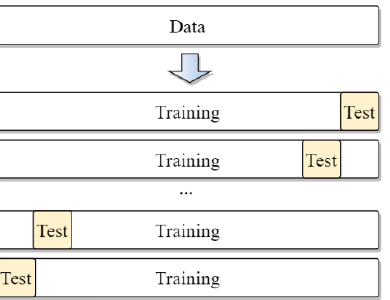
Figure 9. 10-Folder cross-validation.